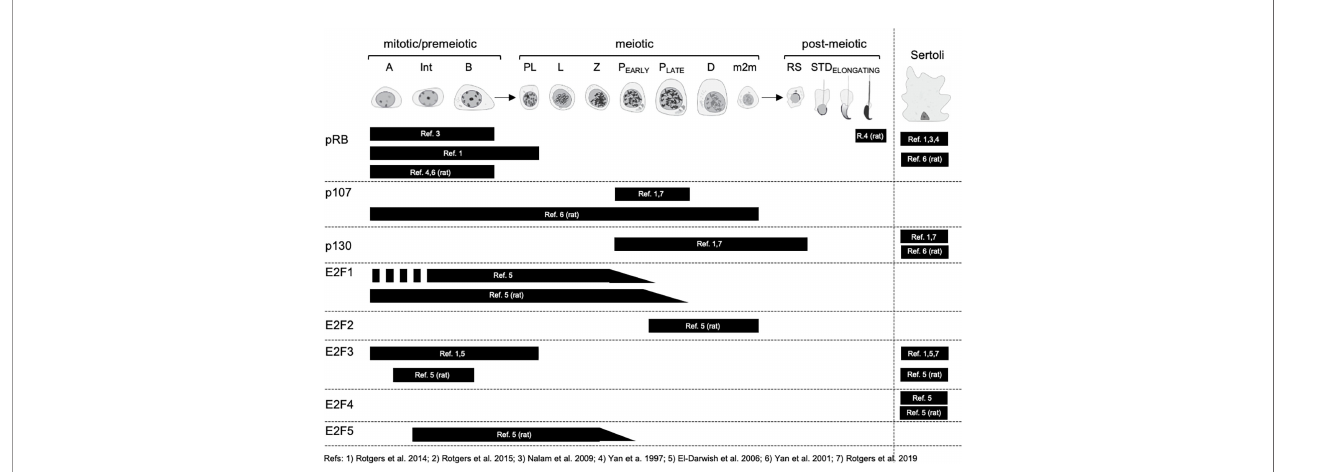
FIGURE 5 | Expression of RB and E2F family proteins in spermatogenic cells and Sertoli cells. Mitotic/premeiotic germ cells are divided into type A (A), type Intermediate (Int) and type B (B) spermatogonia. Meiotic germ cells are presented as preleptotene (Pl), leptotene (L), zygotene (Z), early and late pachytene (P) and diplotene (D) spermatocytes, and secondary spermatocytes, m2m. Post-meiotic germ cells are round spermatids (RS) and elongating spermatids